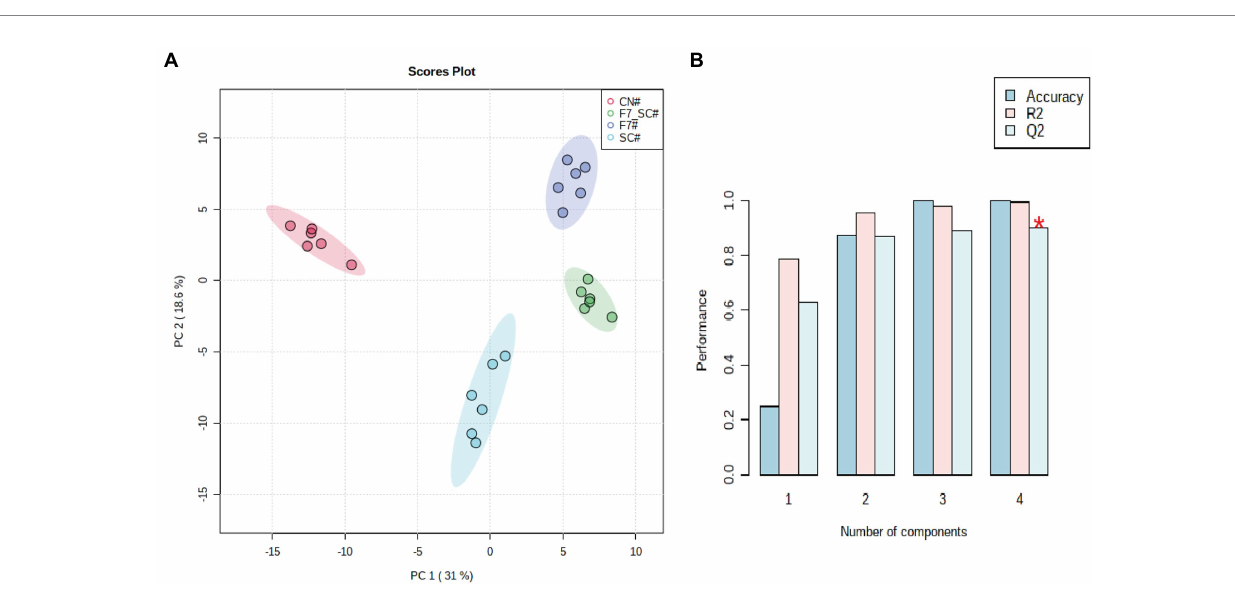
FIGURE 6 Profiling the volatile compositions in FCT with bio-cultivation. Principal component analysis (A) and cross-validation of PLS-DA (R2:0.9945; Q2:0.9355) of the volatile compositions in FCT with bio-cultivation (B)